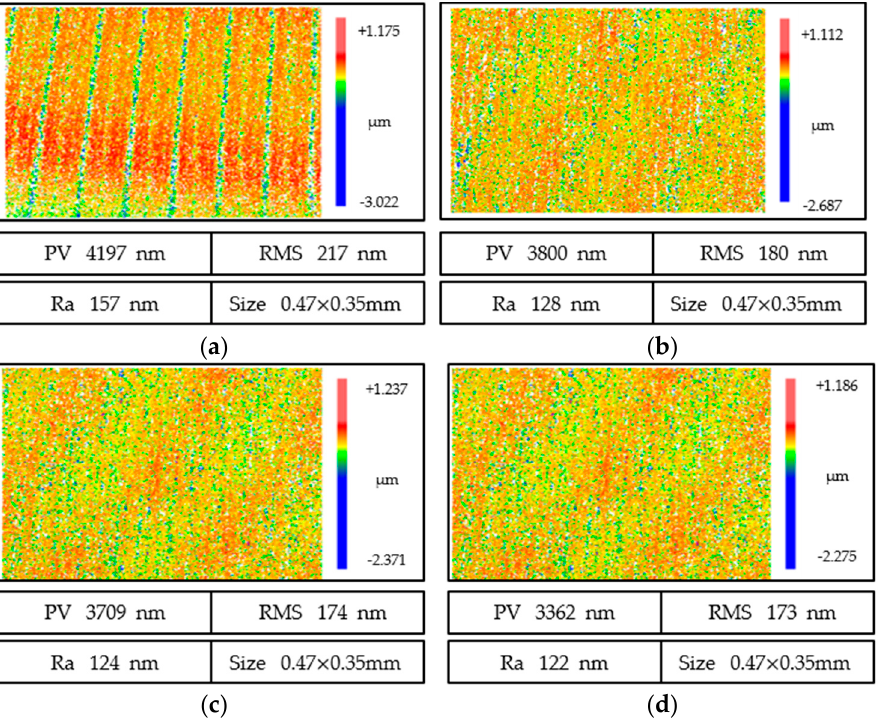
Figure 11. Evolution of the surface quality of grinding marks under different cutting depths for an